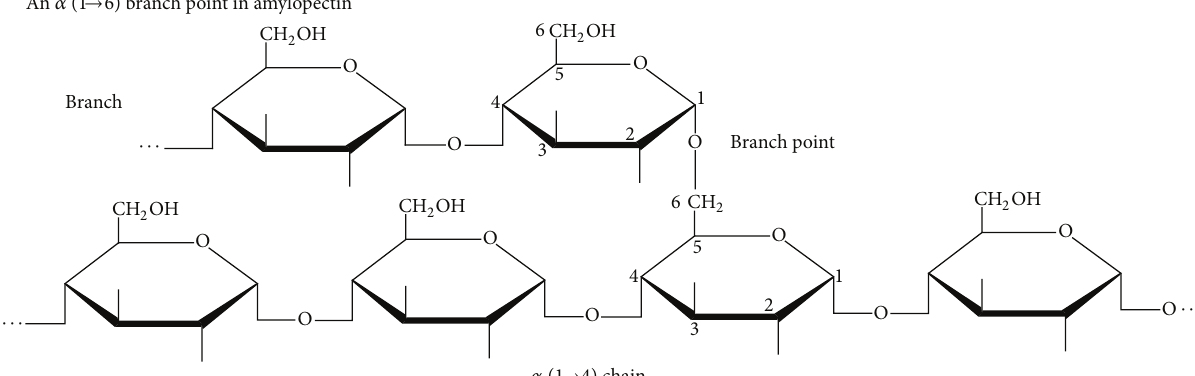
Figure 3: Amylopectin chemical structure showing the point of action by Klebsiella pullulanase enzyme on the 𝛼 -(1 → 6) links (with